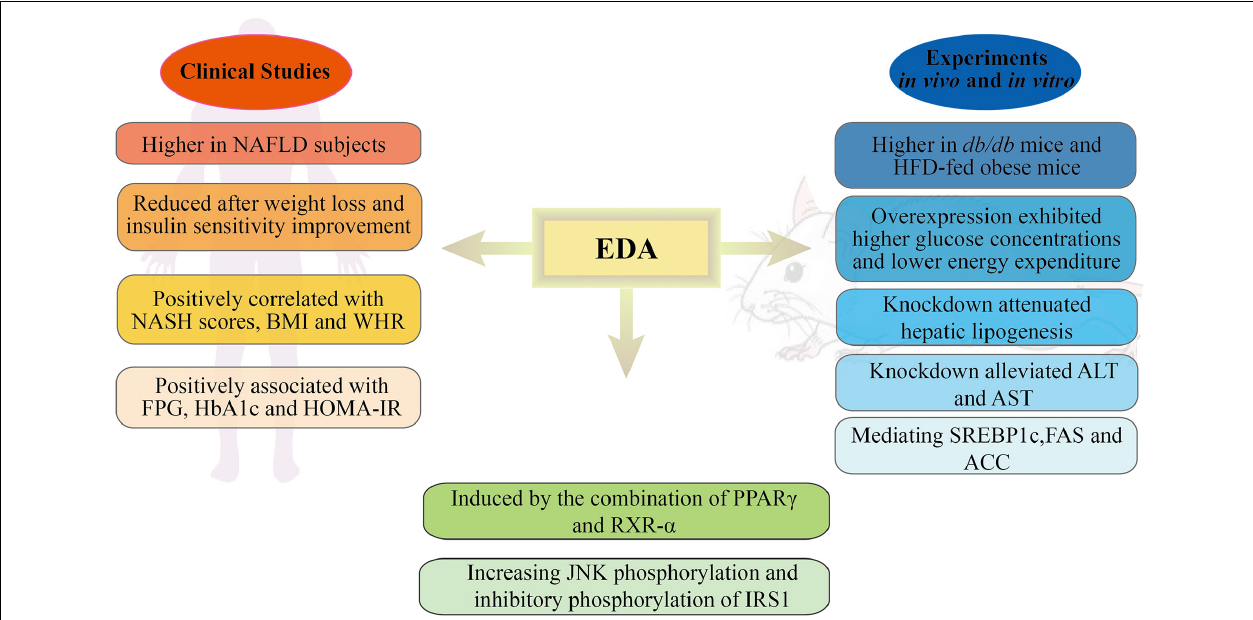
FIGURE 2 | Schematic representation of the roles and mechanisms of EDA in metabolic disorders. NAFLD, non-alcoholic fatty liver disease; NASH, non-alcoholic steatohepatitis; BMI, body mass index; WHR, waist-to-hip ratio; FPG, fasting plasma glucose; HbA1c, hemoglobin A 1c; HOMA-IR, homeostasis model assessment of insulin resistance; HFG, high-fat diet; ALT, alanine transaminase; AST, aspartate transaminase; SREBP1c, sterol regulatory element binding transcription factor 1; FAS, fatty acid synthase; ACC, acetyl-CoA carboxylase; PPAR γ , proliferator-activated receptor γ ; RXR- α , retinoid-X receptor- α ; IRS1, insulin receptor substrate